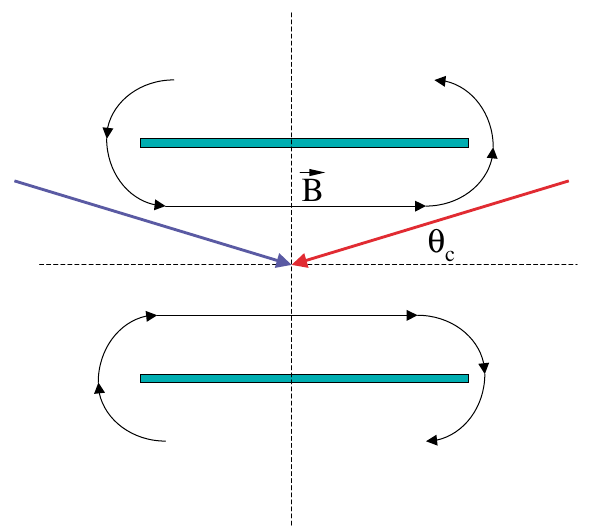
FIG. 3. (Color) Schematic of two beams colliding with a cross- ing angle in the detector